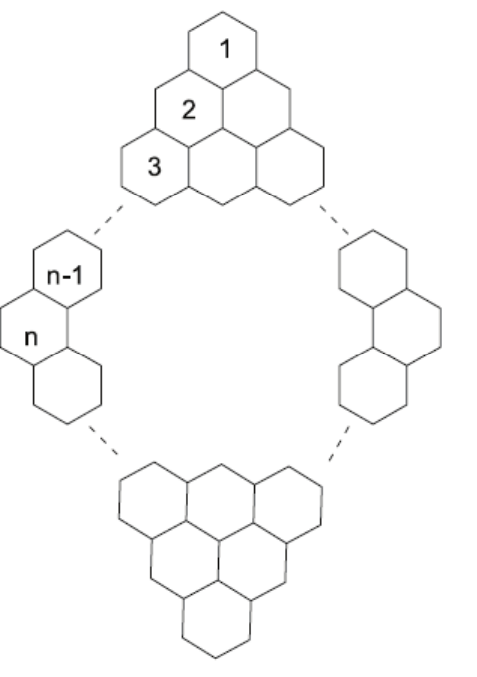
Figure 4: Graph of rhombic benzenoid system having n rows of n hexagons.